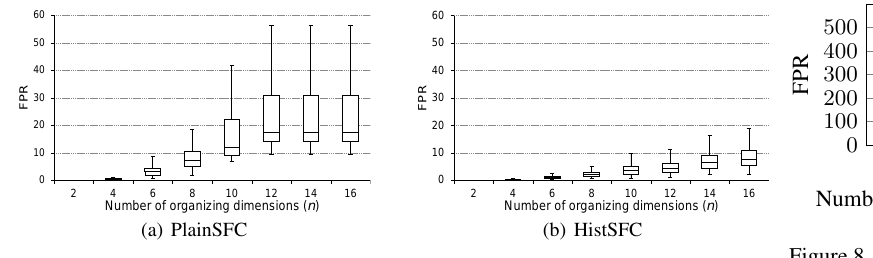
Figure 8. Mean FPR for n - n D query in